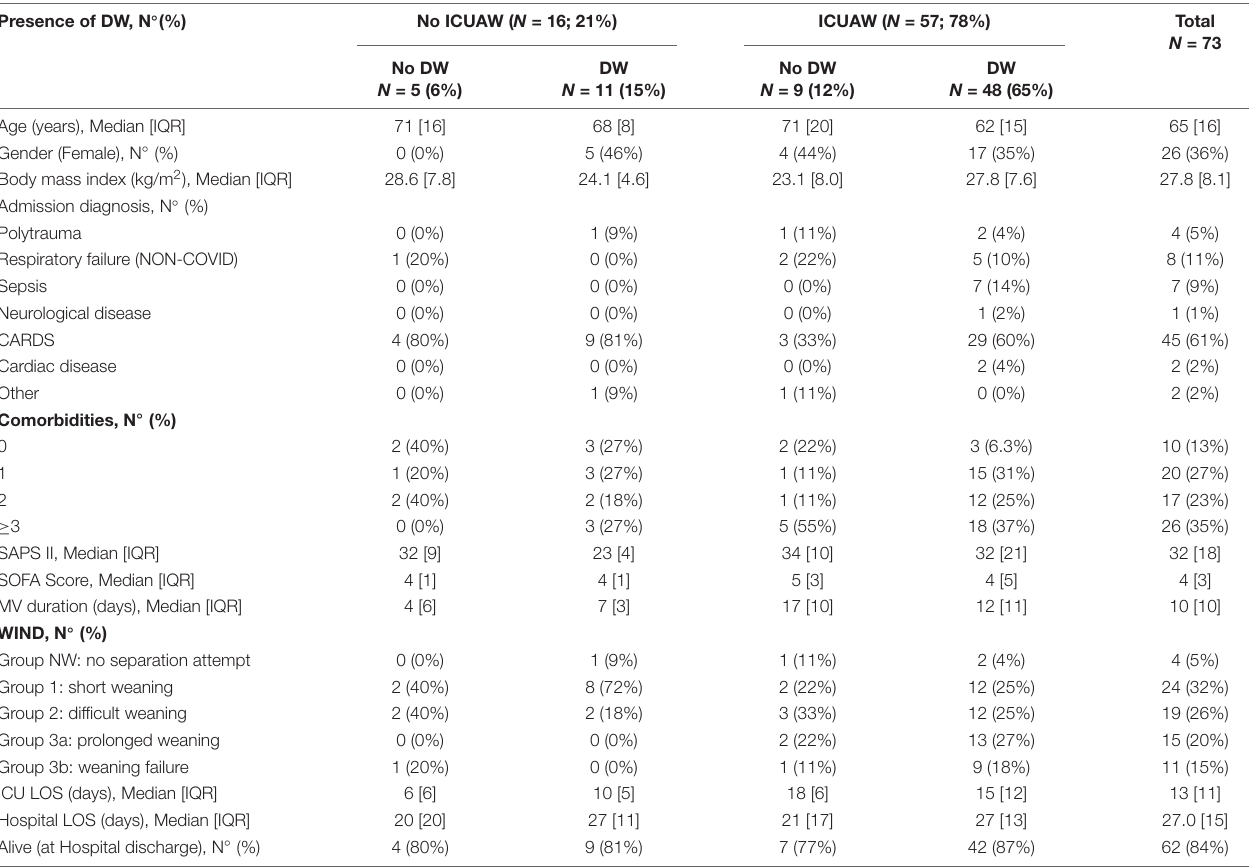
TABLE 1 | Demographics and outcomes